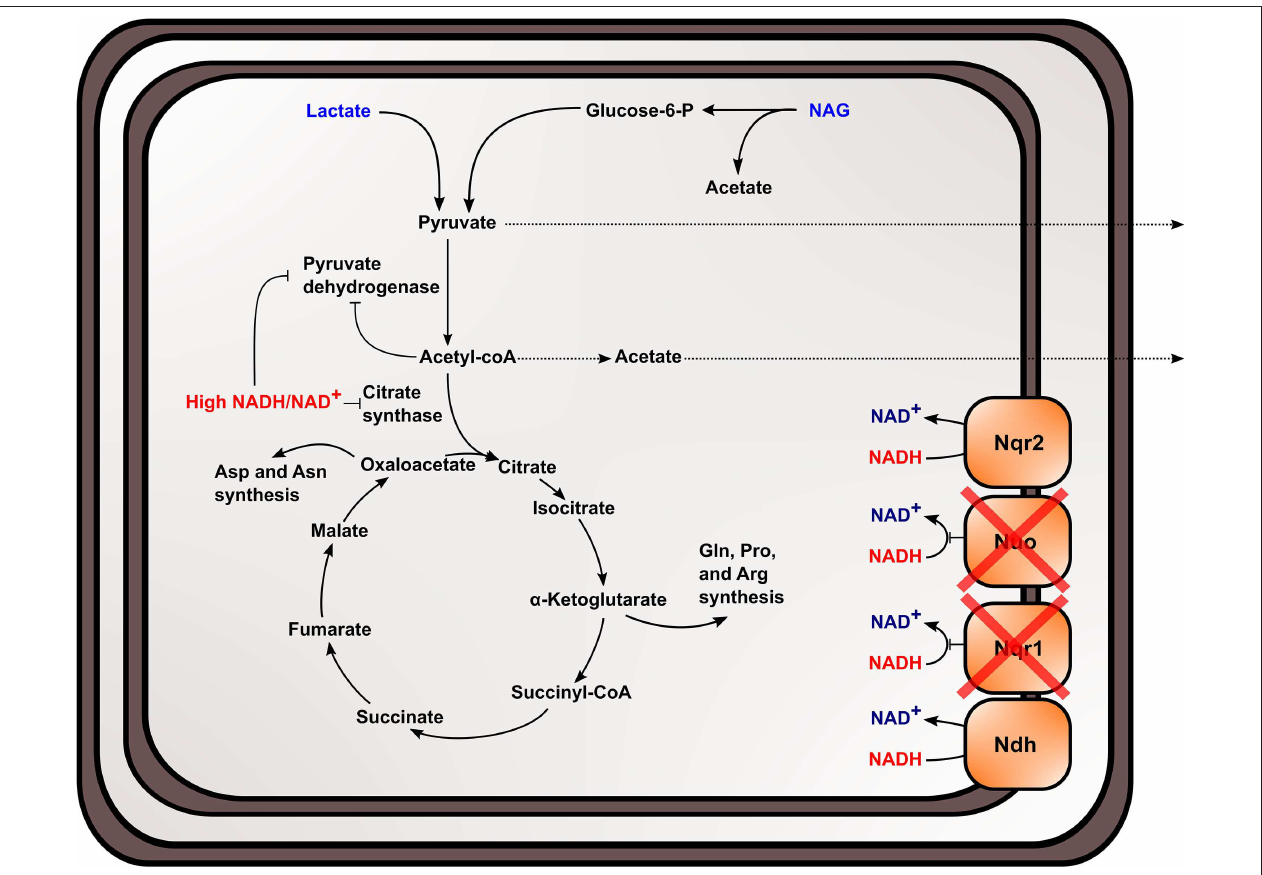
FIGURE 8 | Proposed effect of knocking out NADH dehydrogenases in S. oneidensis MR-1 and the subsequent effects on NADH oxidation, redox state, and TCA cycle inhibition within the cell. and limited [NAD + ] led to overexpression of genes involved in NAD +